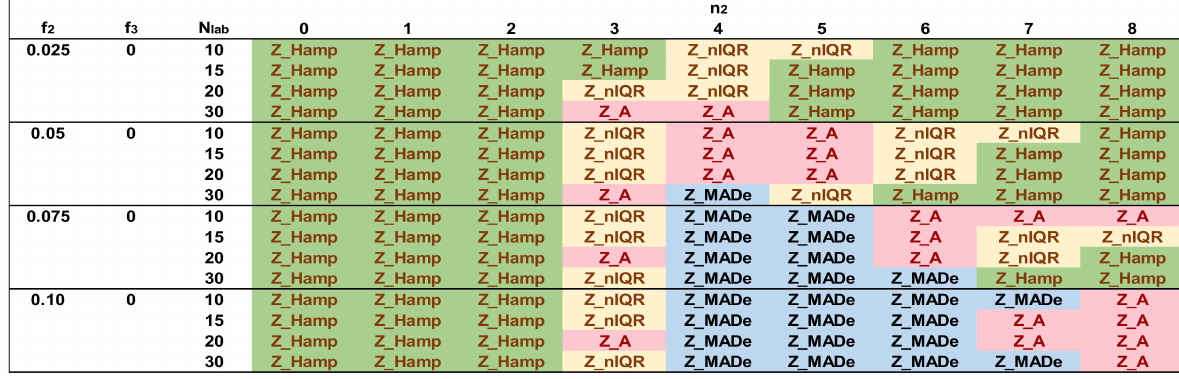
Figure 11. Optimal robust estimators of Zu% for number of standard deviations n 2 = 0 to 8, f 2 = 0.025 to 0.10 and N lab = 10, 15, 20,